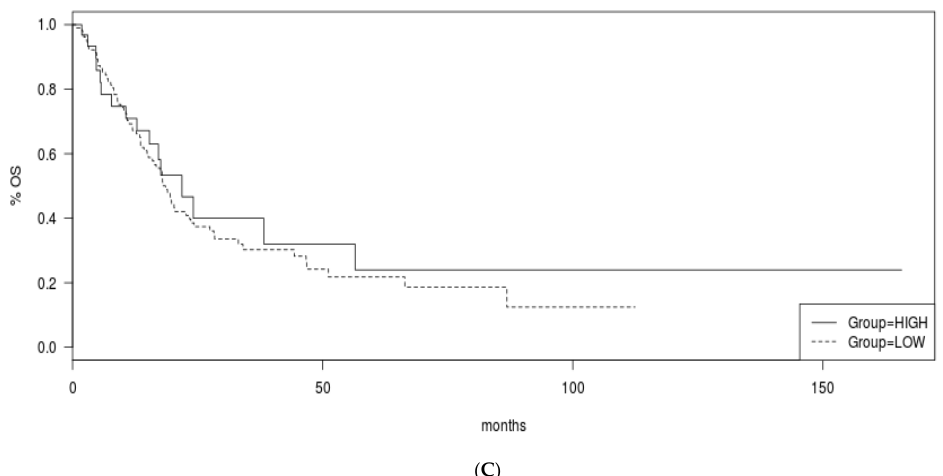
Figure 10. Overall Survival of the high and low TMB groups according to stage. ( A ) Stage II, ( B ) Stage III, ( C ) Stage